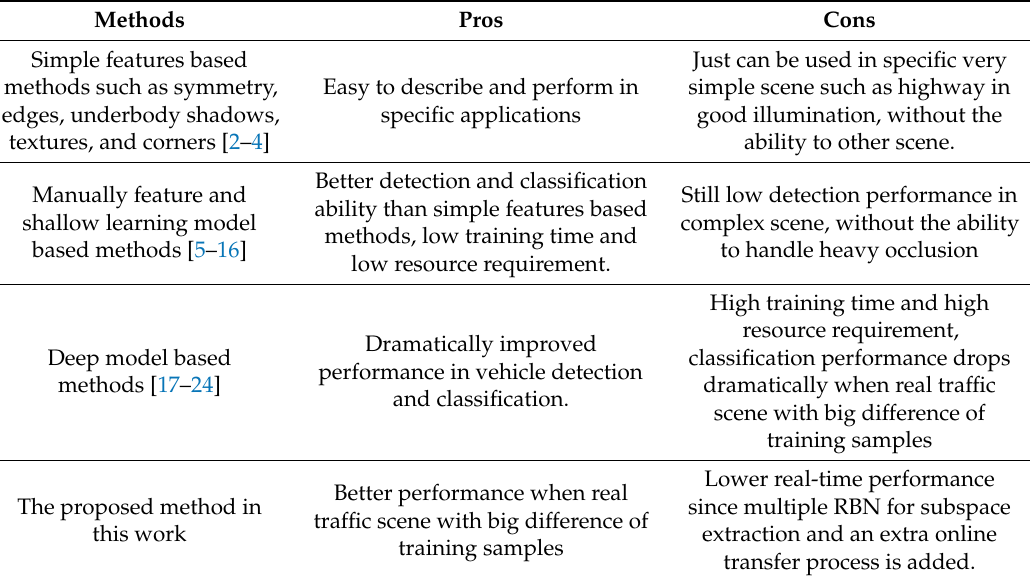
Table 1. Pros and cons of related work and proposed method.